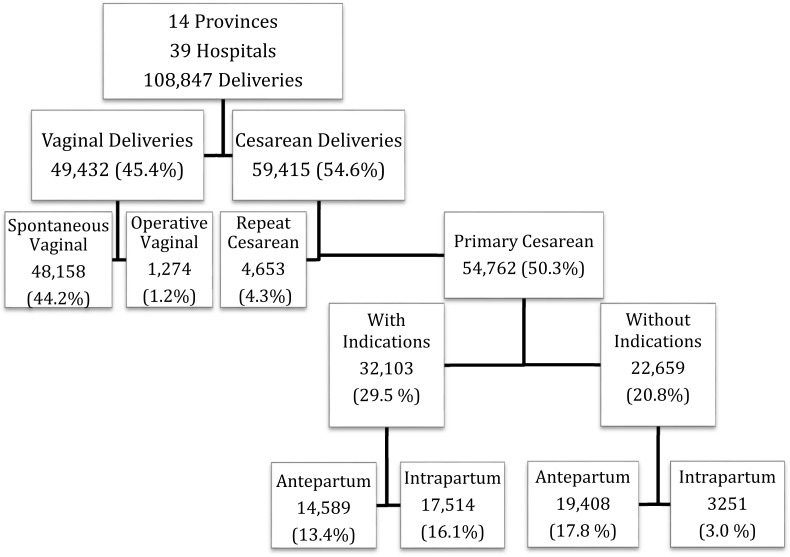
Study design and cesarean delivery rates.